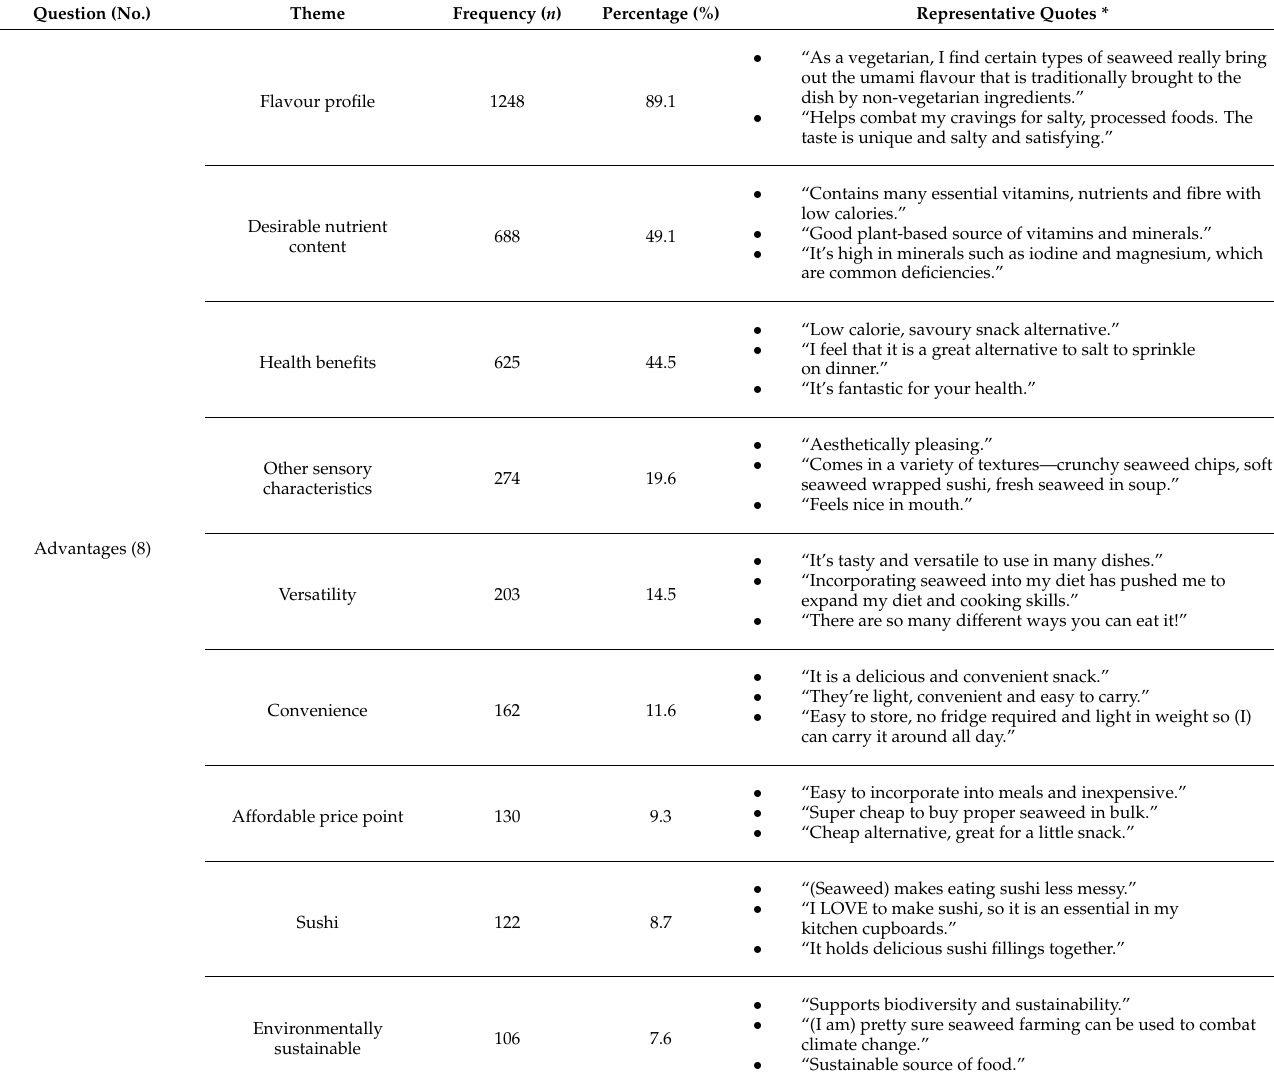
Table 4. Motivators and barriers of seaweed consumption, as reported by